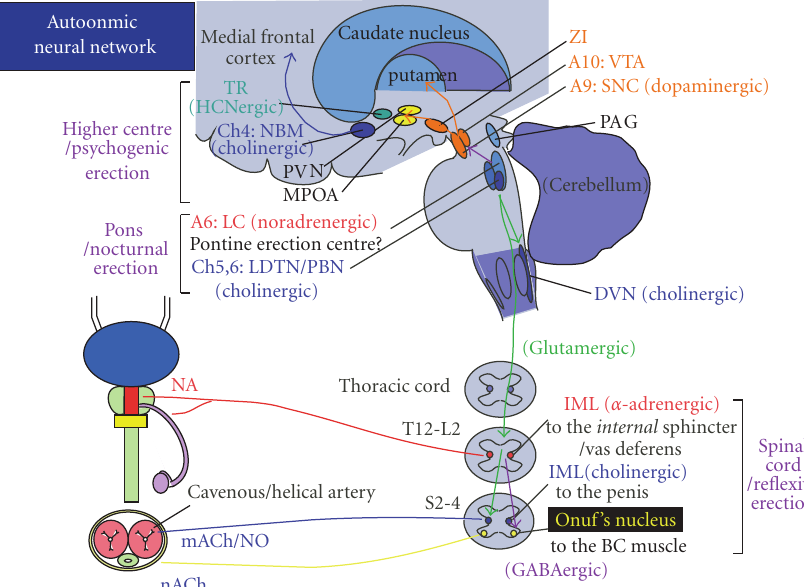
Figure 6: Neural circuitry relevant to erection. PAG, periaqueductal gray; LC, locus coeruleus; NBM, nucleus basalis Meynert; PVN, paraventricular nucleus; MPOA, medial preoptic area; A, adrenergic/noradrenergic; ZI, zona incerta; VTA, ventral tegmental area; SNC, substantia nigra pars compacta; DLTN, dorsolateral tegmental nucleus; PBN, parabrachial nucleus; IML, intermediolateral nucleus; GABA, γ -aminobutyric acid; T, thoracic; L, lumbar; S, sacral; NA, noradrenaline; Ach, acetylcholine; NO, nitric oxide. See